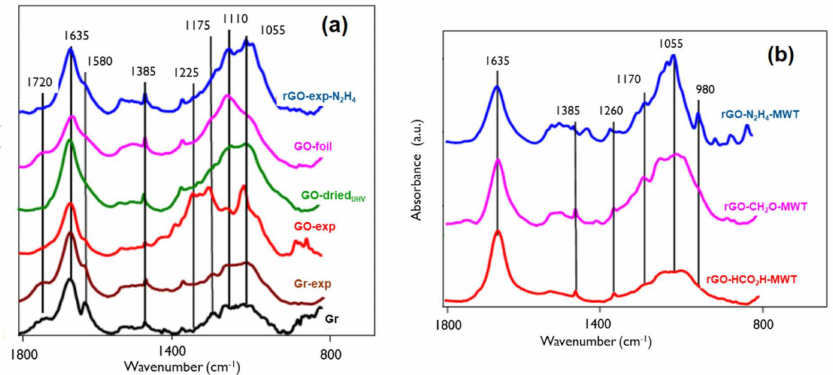
Figure 4. IR spectra of: ( a ) GOs, rGO and graphites, ( b ) rGOs obtained using different reducing agents and microwave treatment